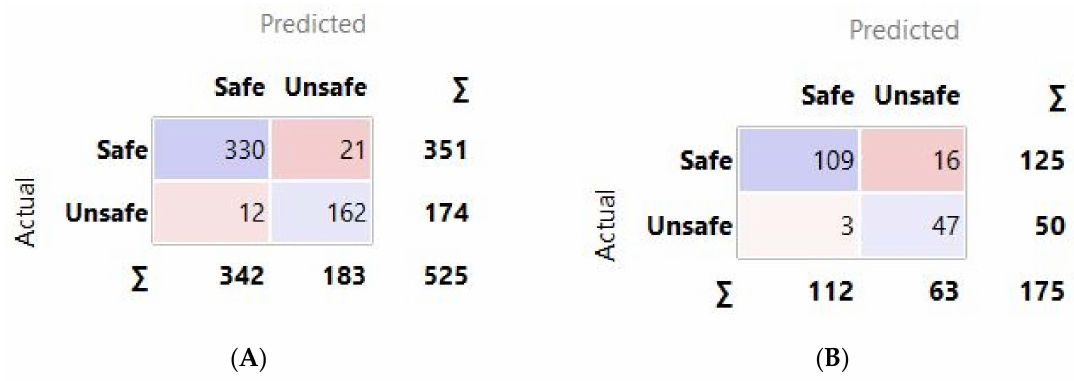
Figure 7. The DT model results for FOS classification: ( A ) Training and ( B )